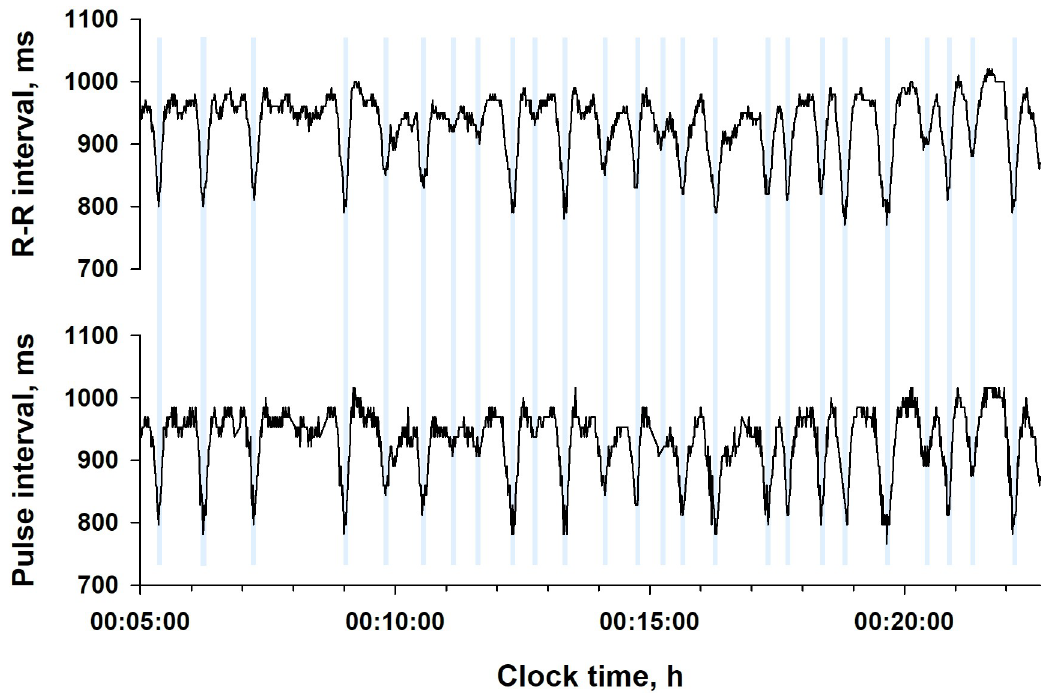
Fig 3. R-R interval and pulse interval time series from simultaneously recoded electrocardiogram (ECG) and PPG in a representative subject (a 66-y male with an AHI of 79.3). Vertical blue lines show the temporal positions of CVHR.